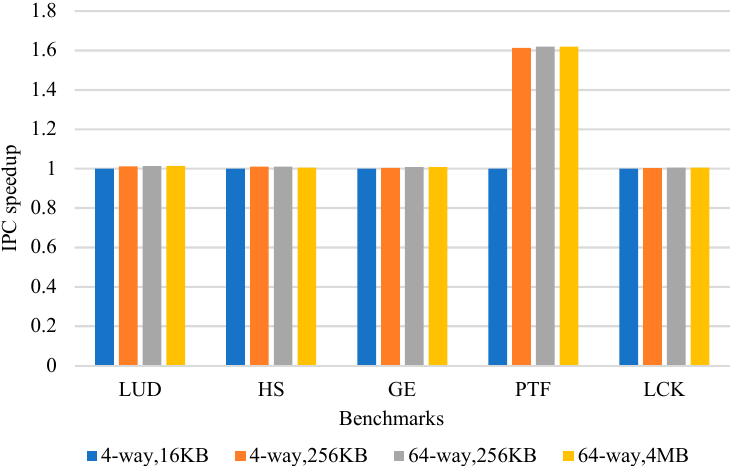
Figure 3. Normalized IPC speedup of different cache capacity and associativity.